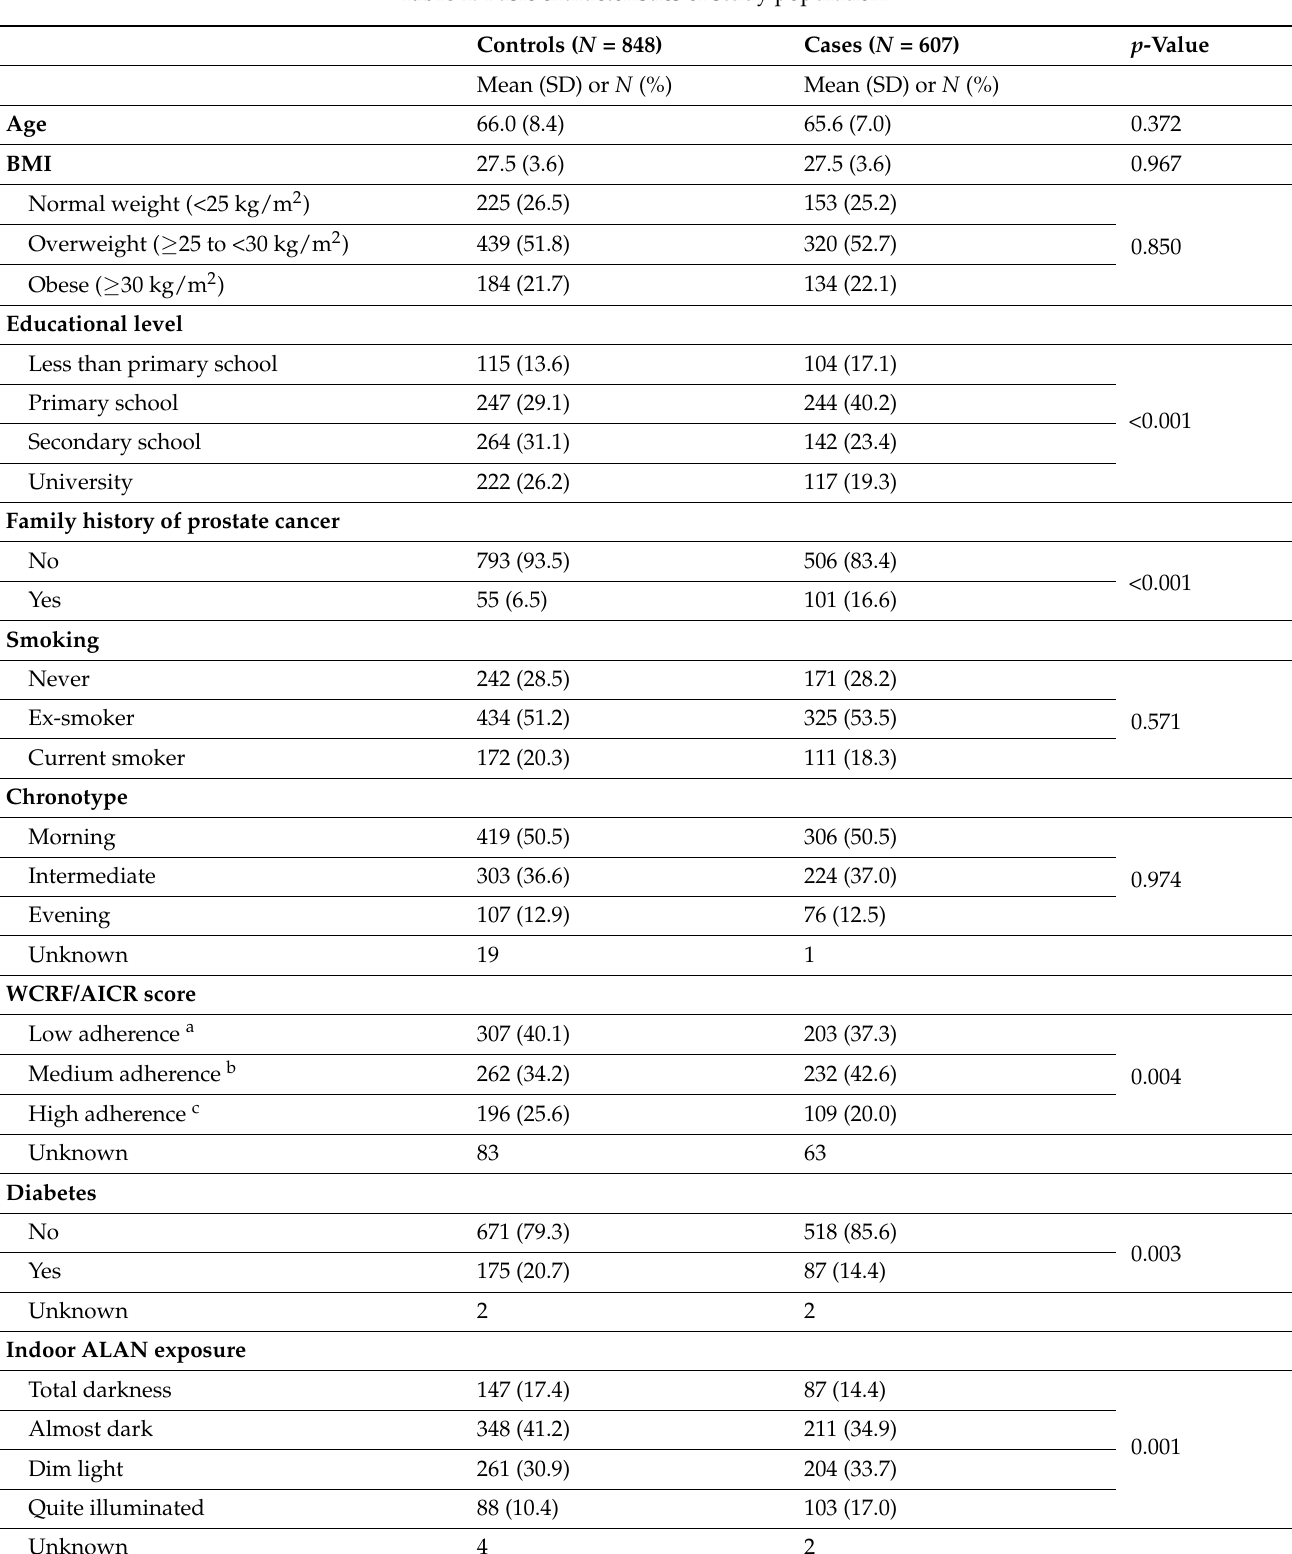
Table 1. Basic characteristics of study